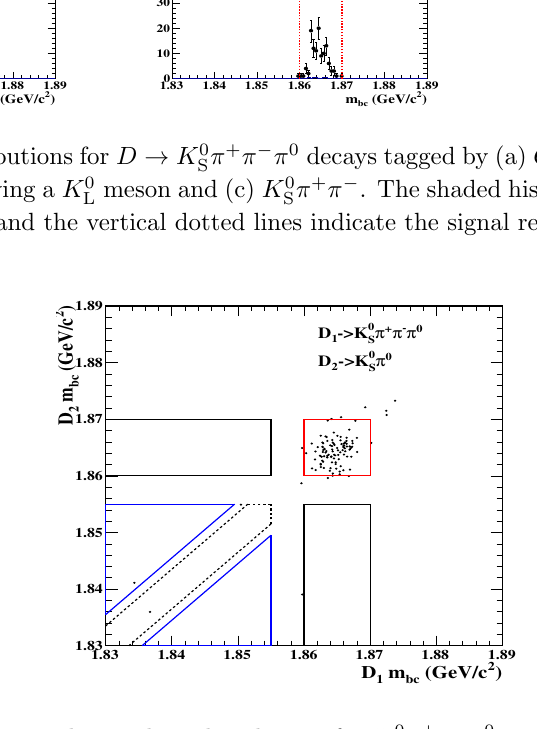
(cid:25) + (cid:25) (cid:0) (cid:25) 0 tagged with K 0 (cid:25) 0 decays. The S S